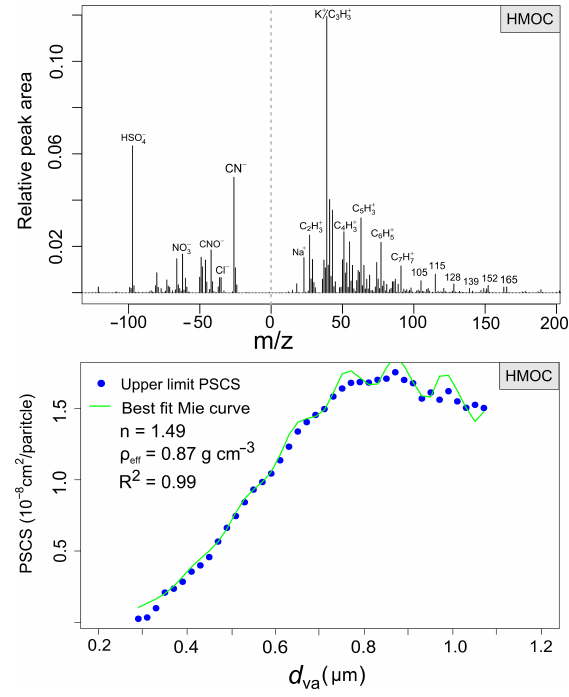
Figure 2. (top) Mass spectra, and (bottom) measured and best-fit theoretical PSCS for